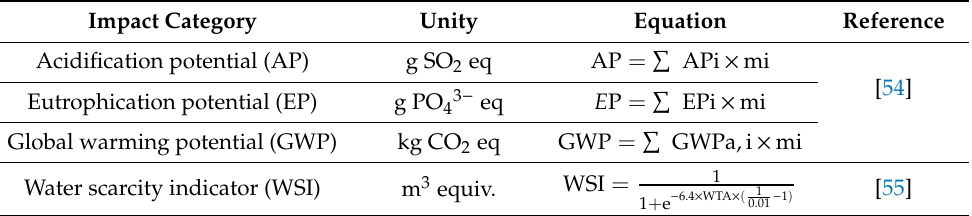
Table 2. Impact categories for quantitative and qualitative assessment of water consumption for wine production.